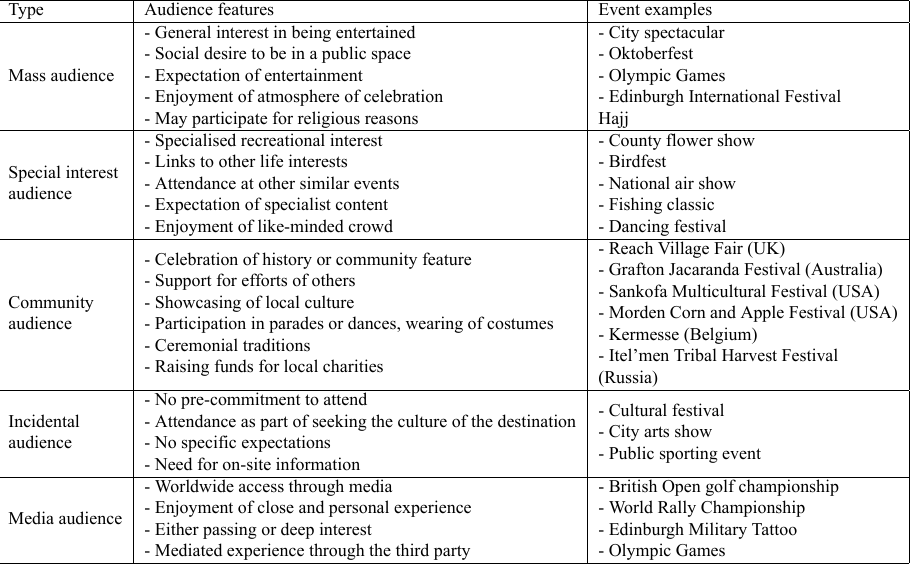
Table 1. Brief characterization of different types of audience. Source: Mackellar (2013).